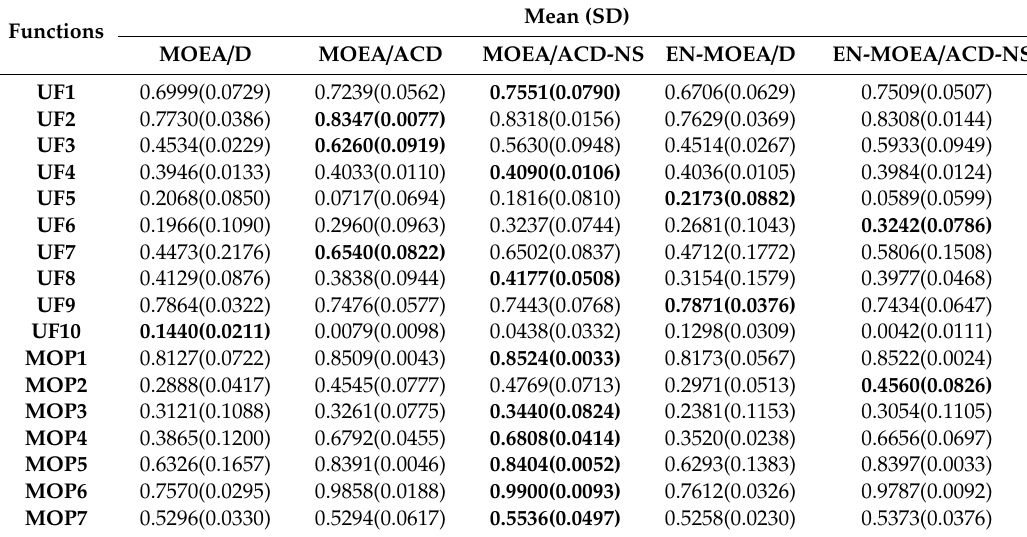
Table 1. Statistical results of hypervolume (HV) metric values obtained by decomposition-based multi-objective evolutionary algorithm (MOEA / D), MOEA / ACD, MOEA / ACD-NS, EN-MOEA / D, and EN-MOEA / ACD-NS (mean and SD). UF = unconstrained function; MOP = multi-objective optimization. The bold number is the optimal value of each set of functions.